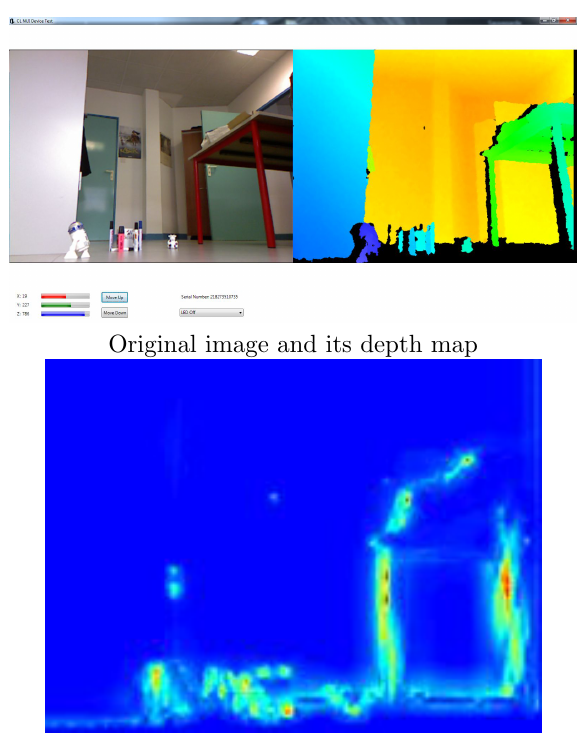
Figure 4. Isolation conspicuity map.